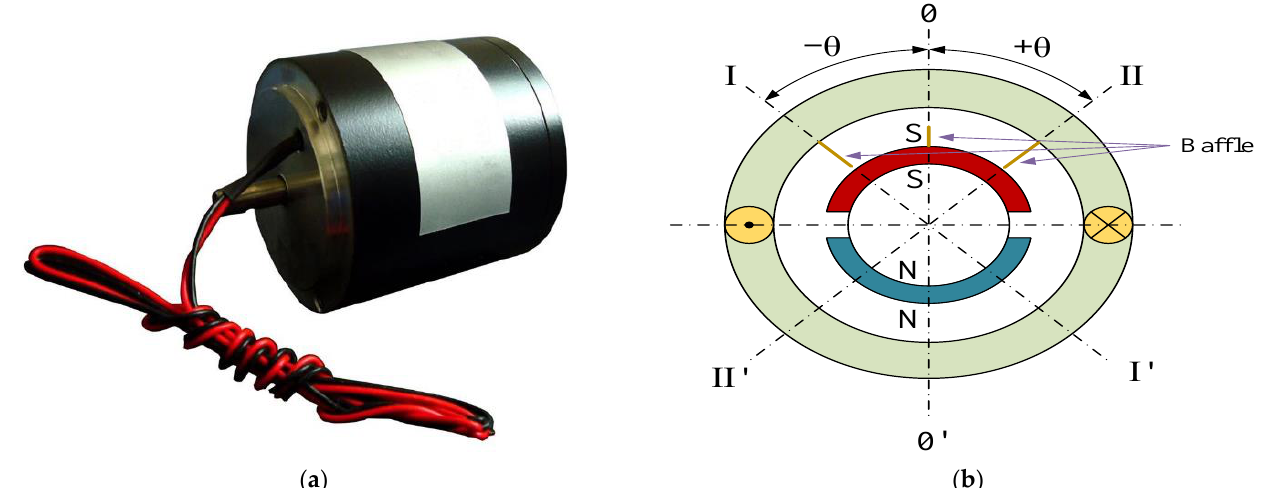
Figure 1. ( a ) 38LXJ01 − Z limited-angle torque motor object; ( b ) Schematic diagram of motor structure section.